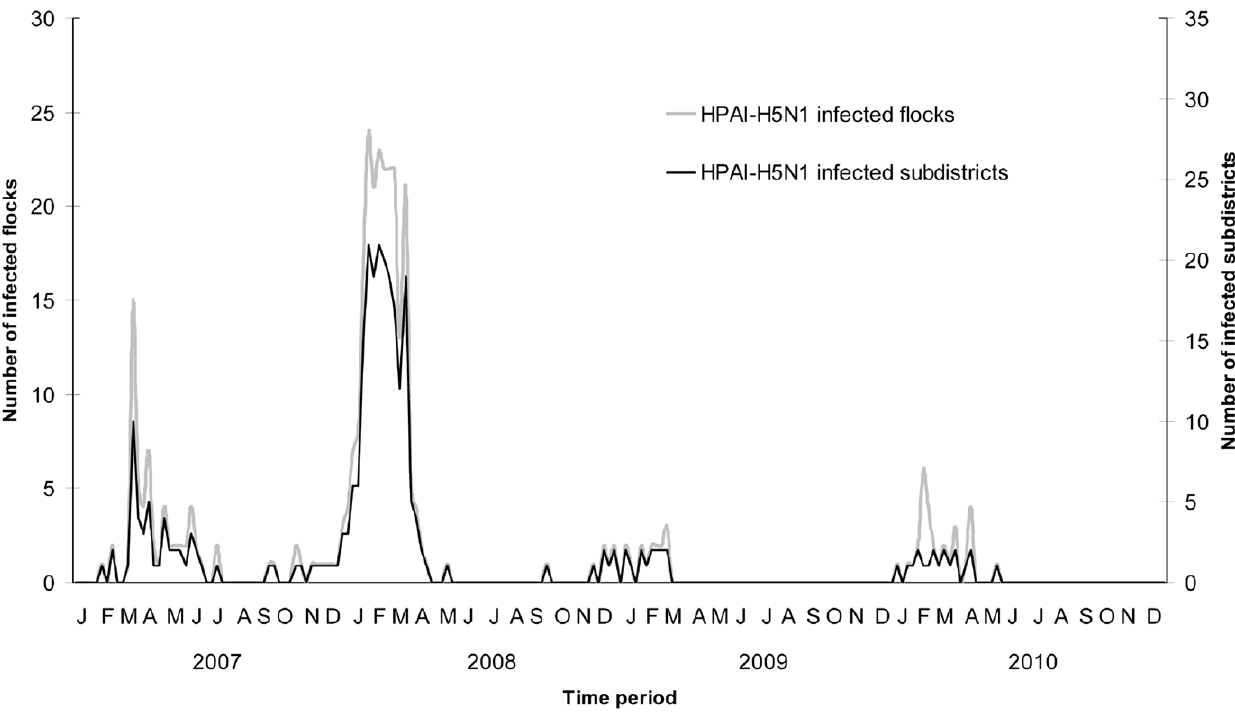
Figure 1. Temporal distribution of the weekly H5N1-HPAI virus outbreak records reported in Bangladesh.